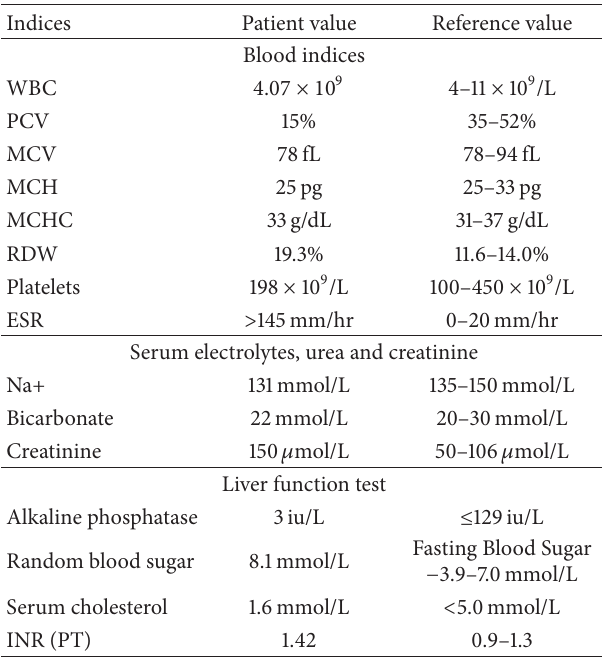
Table 1: The results of initial blood